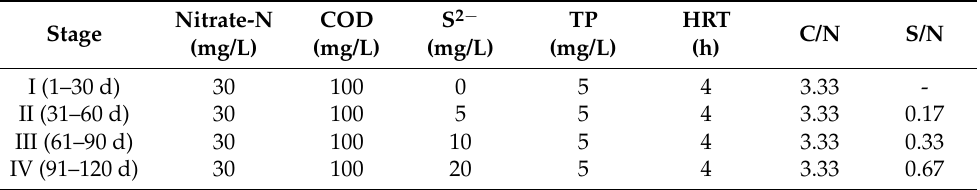
Table 1. Influent conditions of the UASB reactor during different stages.